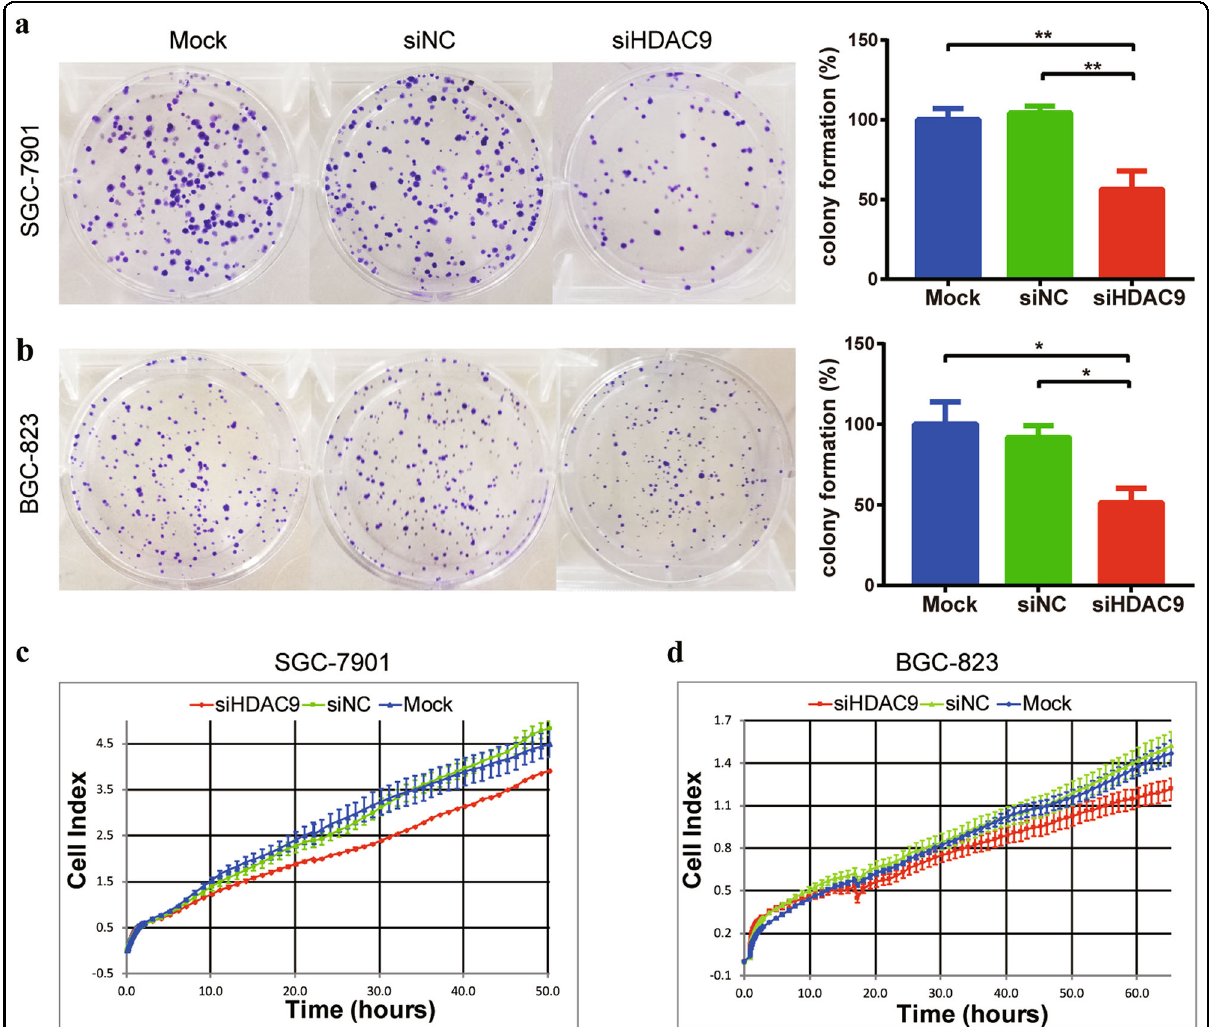
Fig. 5 HDAC9 knockdown inhibited cell colony formation and proliferation. a SGC-7901 cells transiently transfected with HDAC9-speci fi c siRNA (siHDAC9) showed a lower colony formation capacity than cells transfected with nontargeting siRNA (siNC) or mock transfection control (mock) cells. The relative colony formation numbers were calculated by comparison with the mock group. b Silencing of HDAC9 also suppressed colony formation in BGC-823 cells. c , d The cell index parameter used to represent the number of attached viable cells was recorded in real time. The results showed a signi fi cantly lower rate of GC cell proliferation following transfection with siHDAC9 than in cells transfected with siNC and mock transfection control cells. The error bars indicate the means ± SDs; * p < 0.05, ** p < 0.01 versus the control